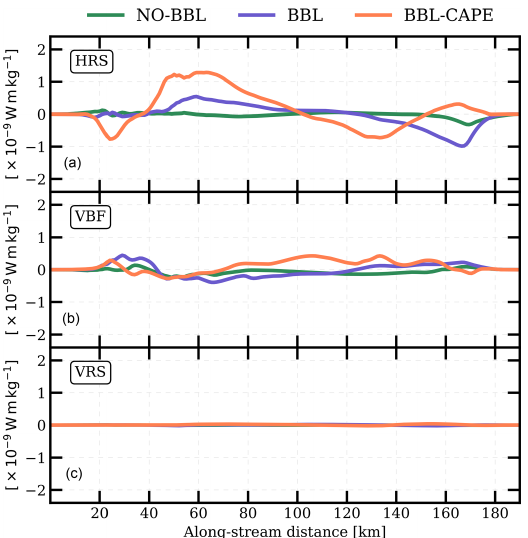
Figure 6. (a) Horizontal Reynolds stress, (b) vertical Reynolds stress and (c) vertical buoyancy flux integrated between 100 and 300m depth in the along-filament direction.